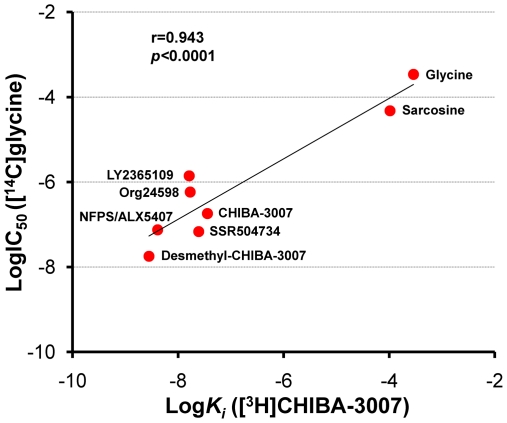
Comparison between the potency of various drugs for inhibiting [3H]CHIBA-3007 binding and [14C]glycine uptake into the rat brain membranes.Data are from Table 1 and Table 2. There was a significant (r = 0.943, p<0.0001) correlation between the potency for inhibiting of 8 compounds (desmethyl-CHIBA-3007, CHIBA-3007, NFPS/ALX5407, SSR504734, Org24598, LY2365109, sarcosine and glycine) for [3H]CHIBA-3007 binding and [14C]glycine uptake.